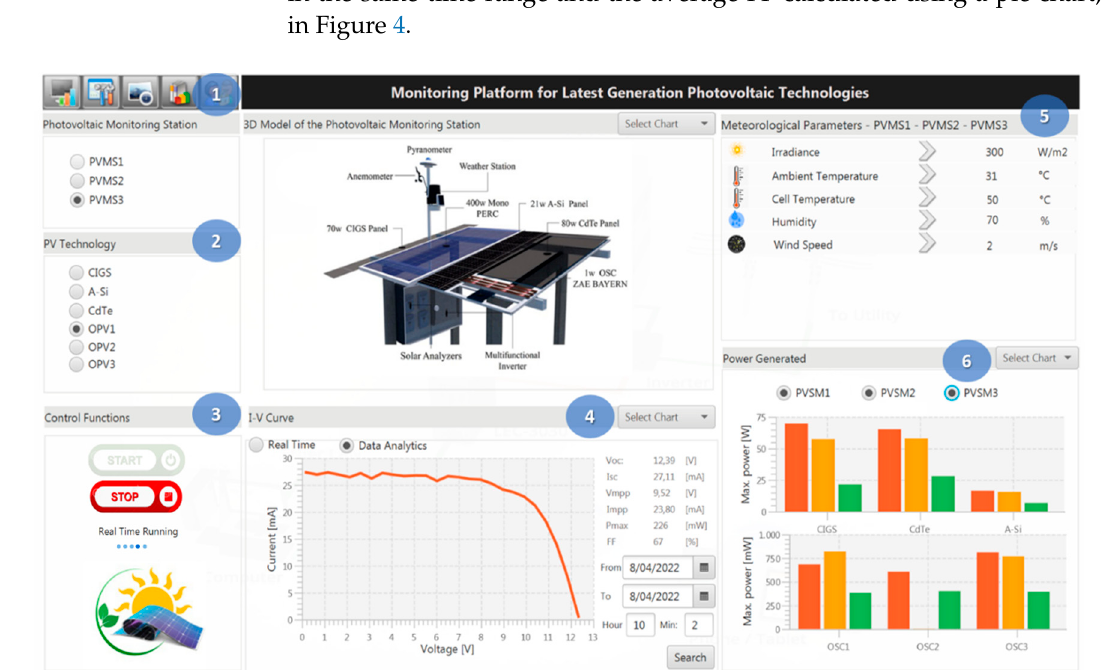
Figure 3. Main window of software user interface receiving real-time data from PVMS1.